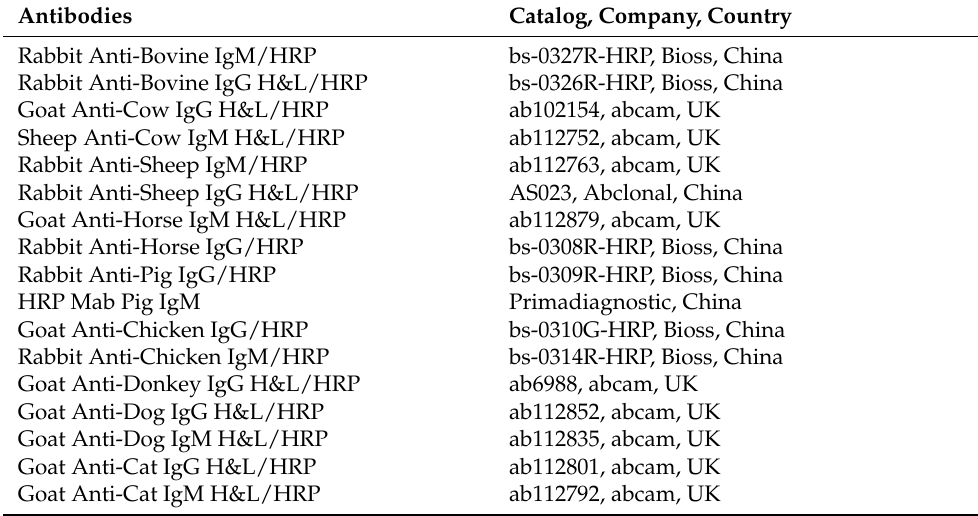
Table 1. Secondary antibodies used in this